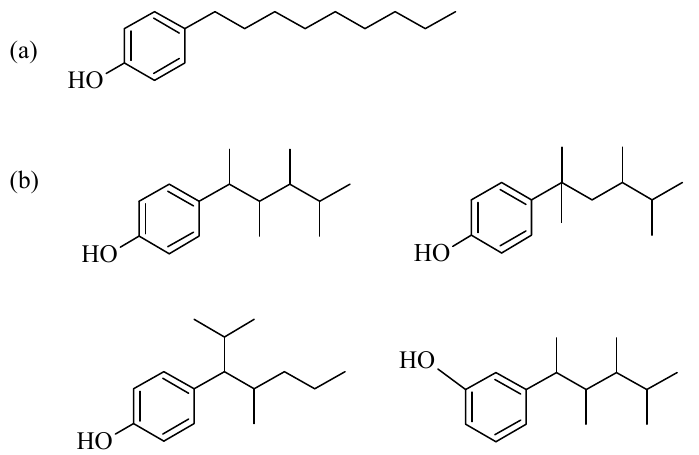
Figure 1. Chemical structure of 4-nonylphenol (4-NPhOH) ( a ); chain and position isomers of nonylphenol ( b ).